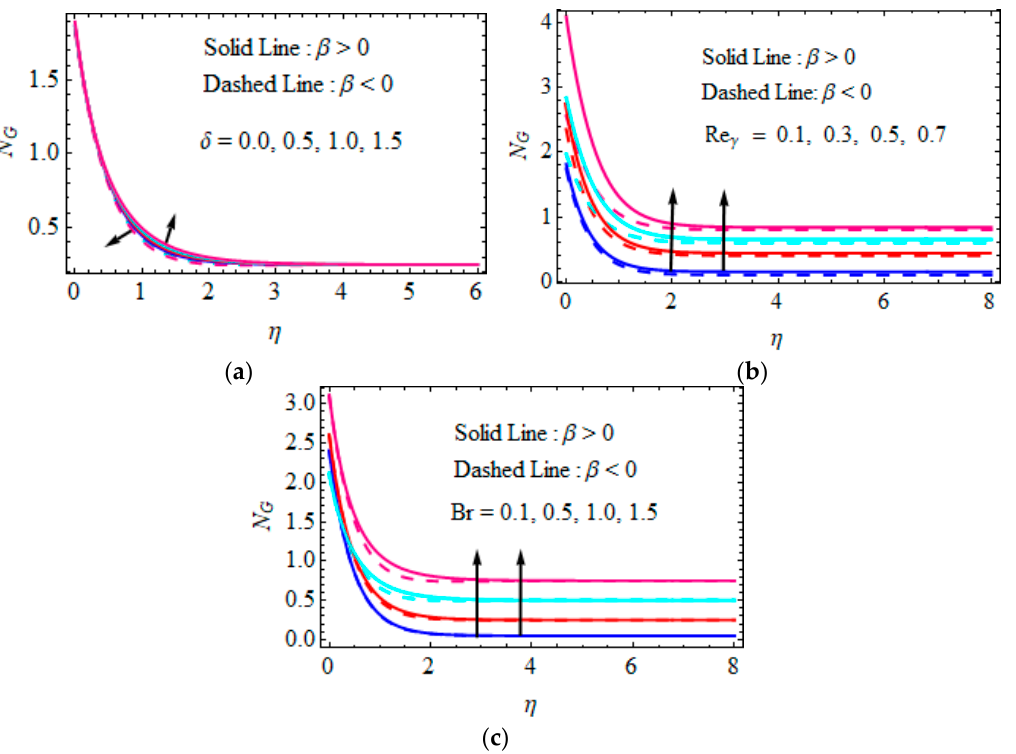
Figure 7. ( a – c ) The impact of the numerous variables of N G : ( a ) δ , ( b ) Re γ and ( c ) Br